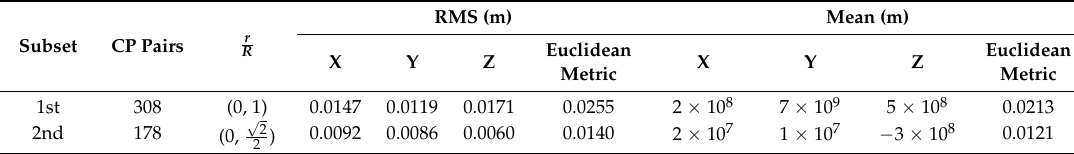
Table 3. Orientation accuracies in the two subsets of dataset1. The RMS of the Euclidean metric equals the absolute mean error in Table 2. The mean of the Euclidean metric equals the standard deviation in Table 2.